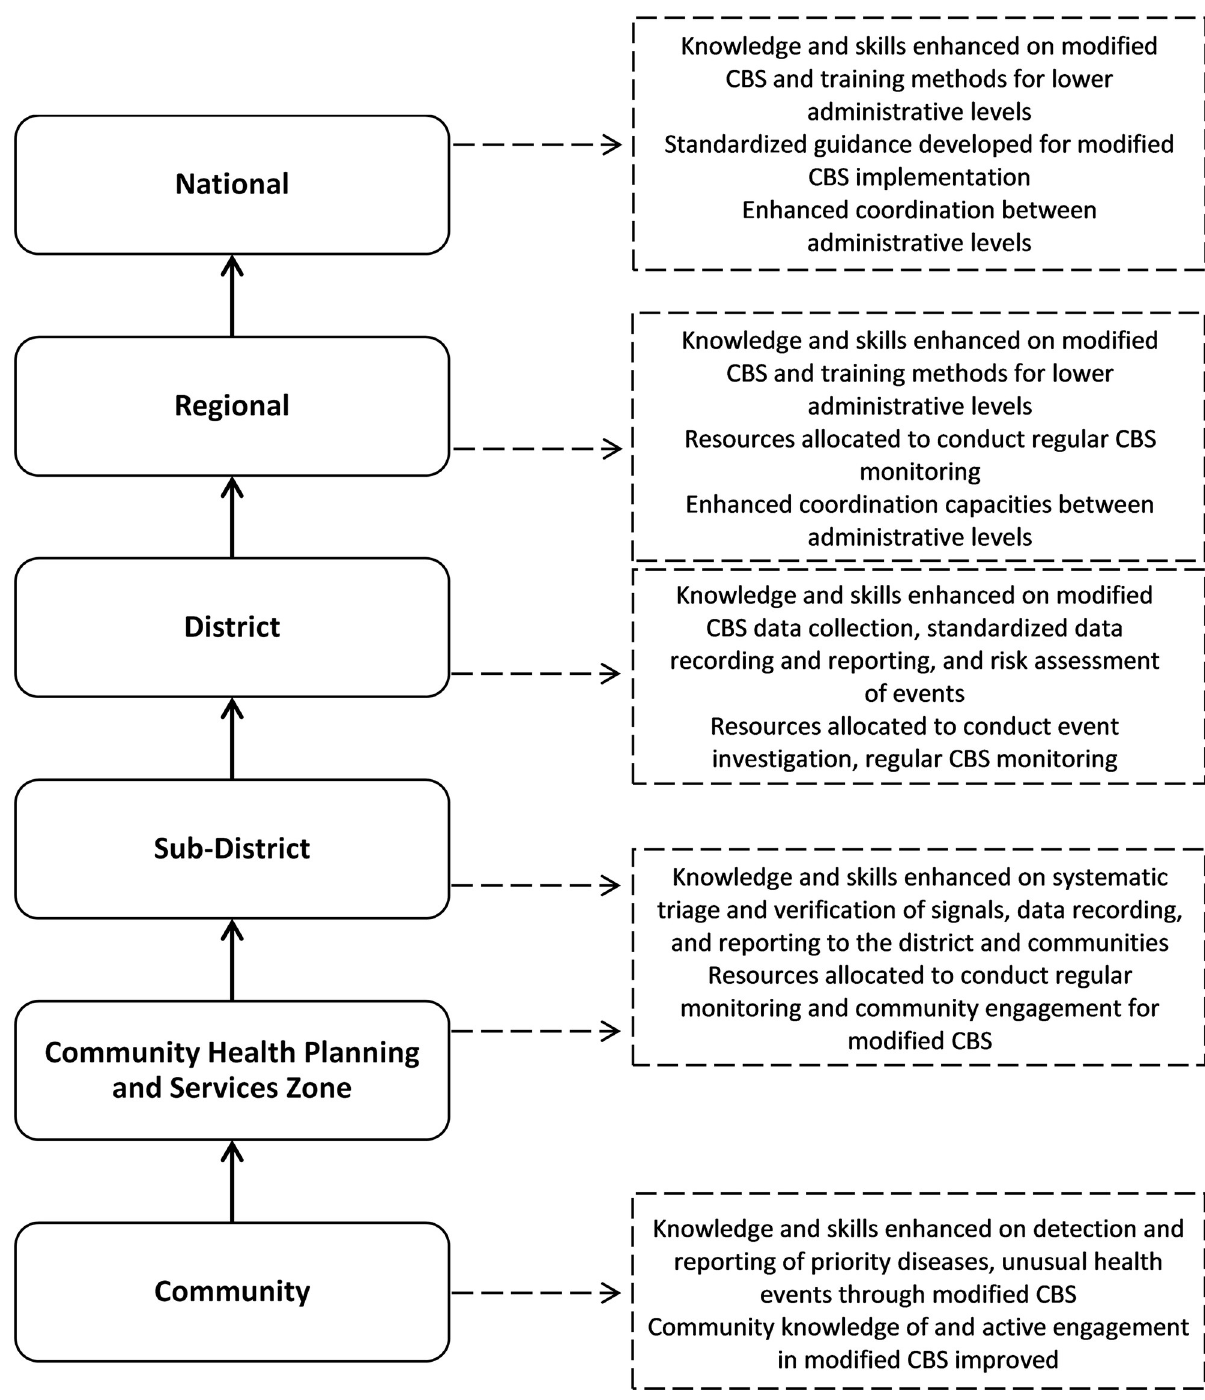
Fig 2. Surveillance and reporting structure in Ghana (left); capacities improved through modified CBS at each administrative level shown in dashed boxes (right).